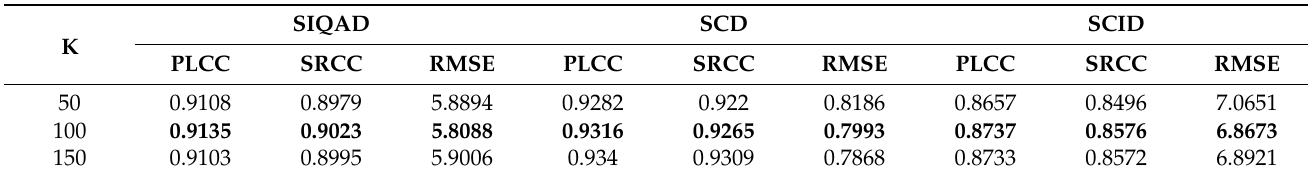
Table 9. Prediction performance with different values of K.